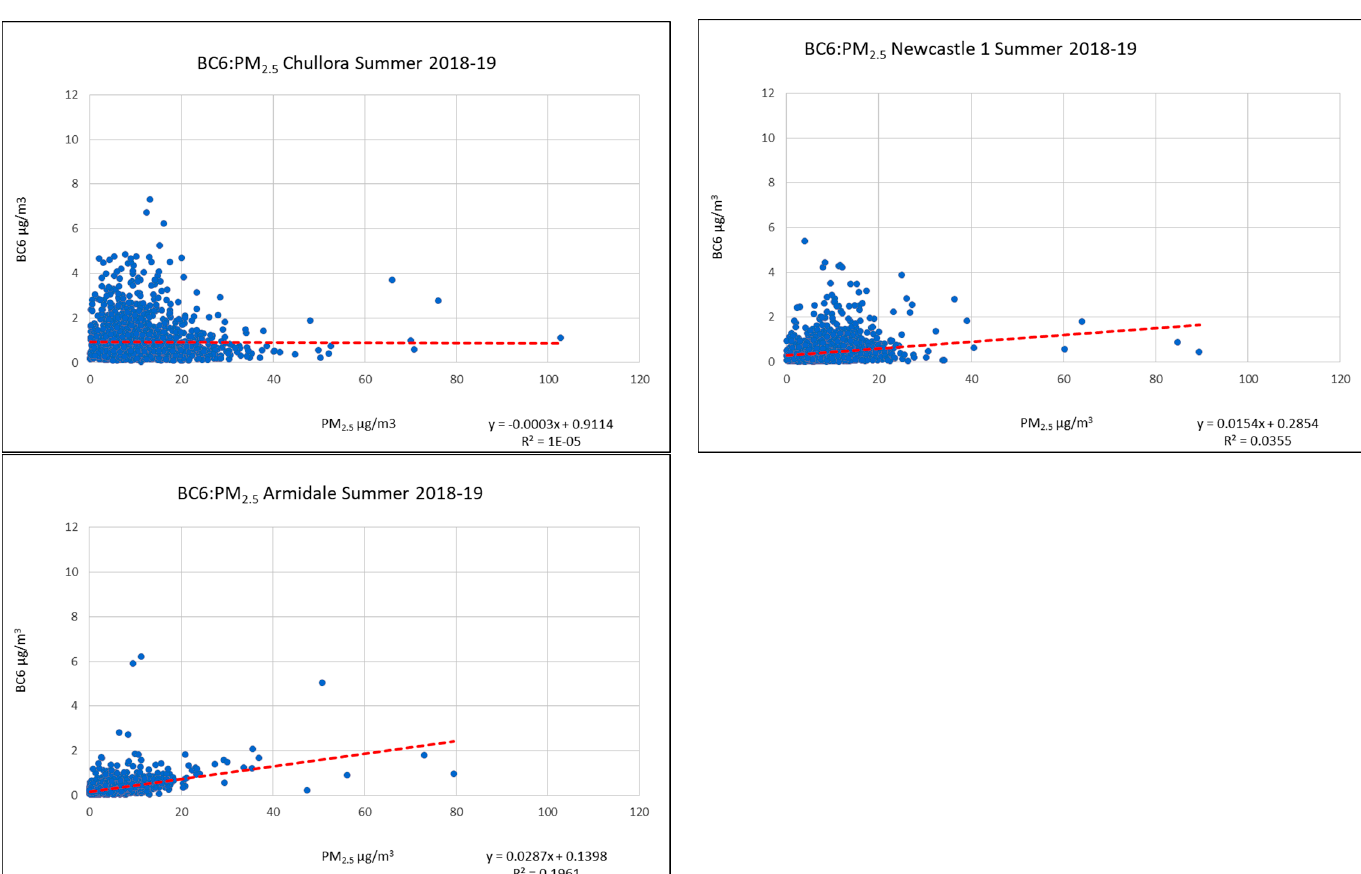
Figure 5. Regression of BC versus PM 2.5 during summer period. There is little or no correlation between BC and PM 2.5 hourly concentration during summer. There are some high peaks of BC at Armidale due to bushfires occurring in the north west of Armidale in February.